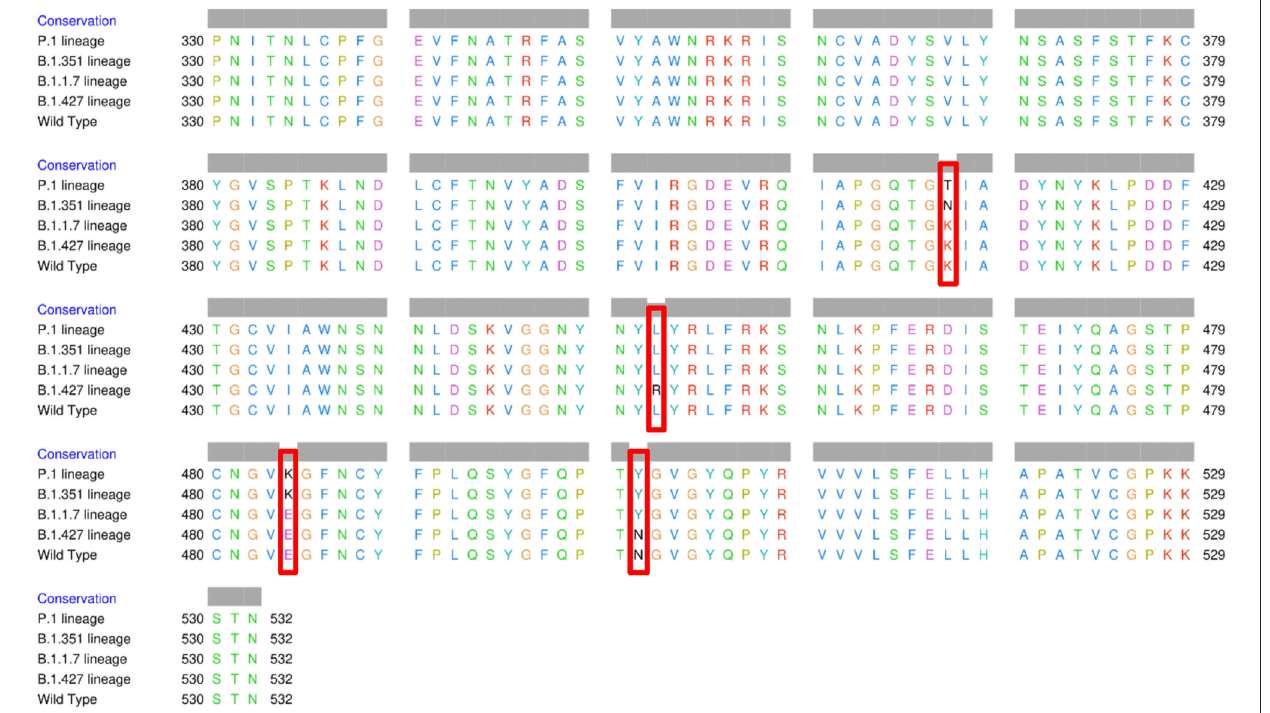
Frontiers in Pharmacology |